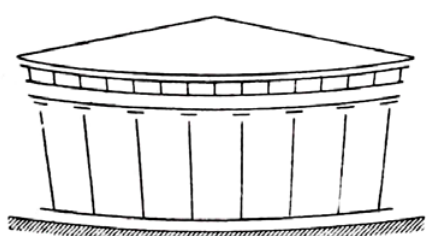
fig. 14. Substitution of curves and horizontal lines in the Parthenon façade (Choisy 1899: 407). Note: representation of the perceived curvature of a Greek temple that was not optically corrected.